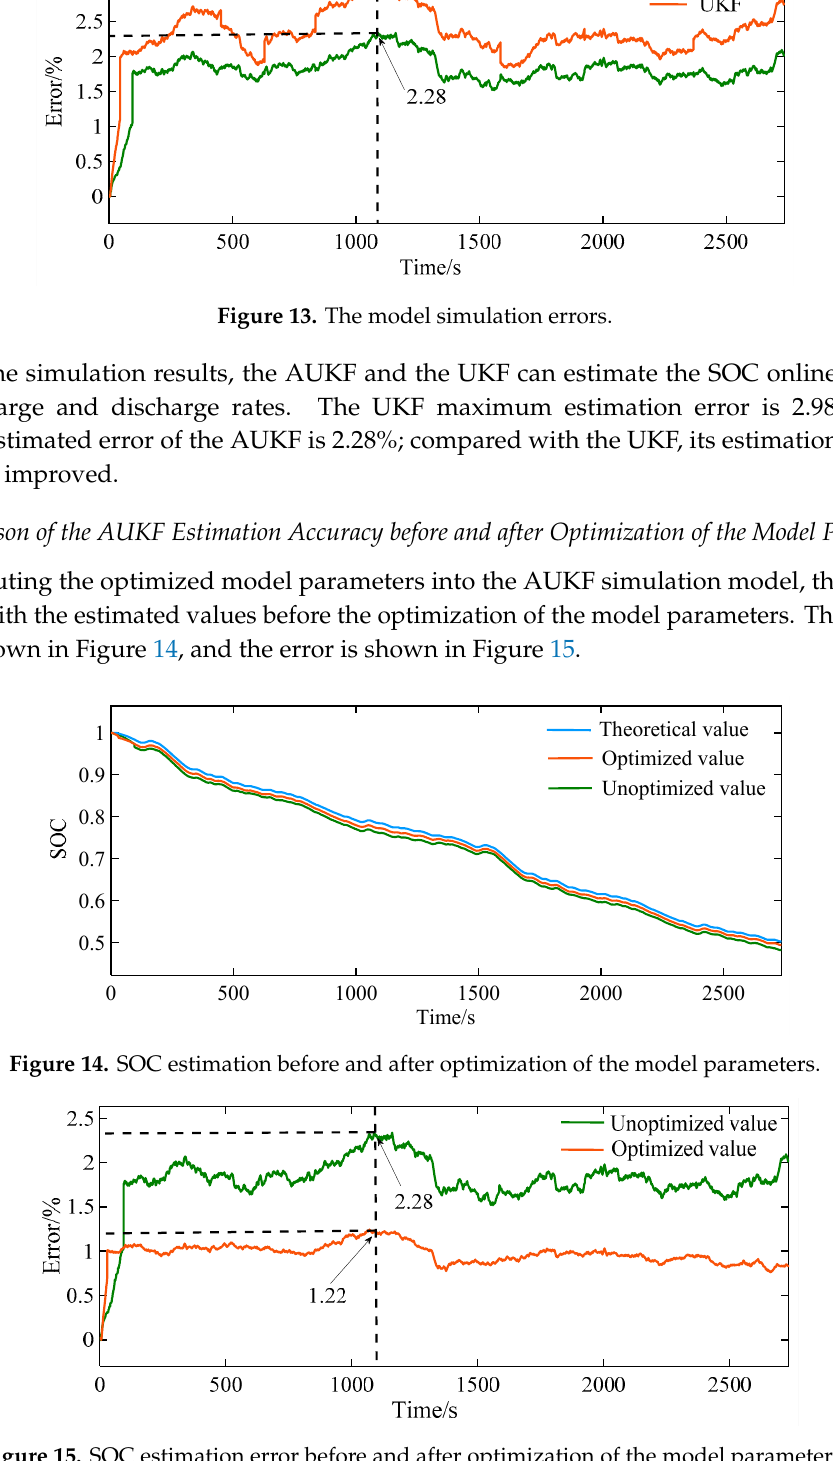
Figure 12. The model simulation results.